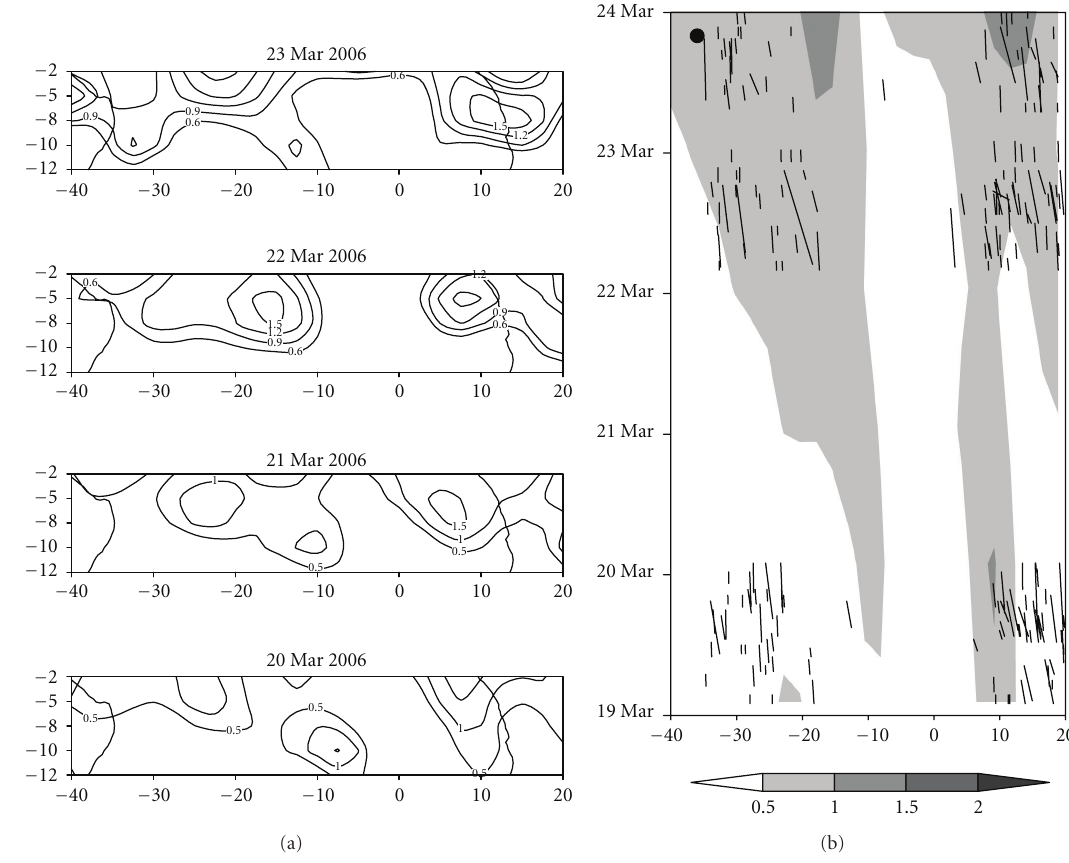
Figure 5: Zoom over the event of 20–23 March 2006: (a) daily pattern of the 700 hPa unfiltered positive vorticity ( × 10 − 5 s − 1 ); (b) the cor- responding time-longitude diagram along 40 ◦ W − 20 ◦ E averaged on 2.5 ◦ N − 12 ◦ 5S. The date of the first day of strong rainfall over ENEB is marked as dot. The westward MCS trajectories ( > 2 hours) are plotted.